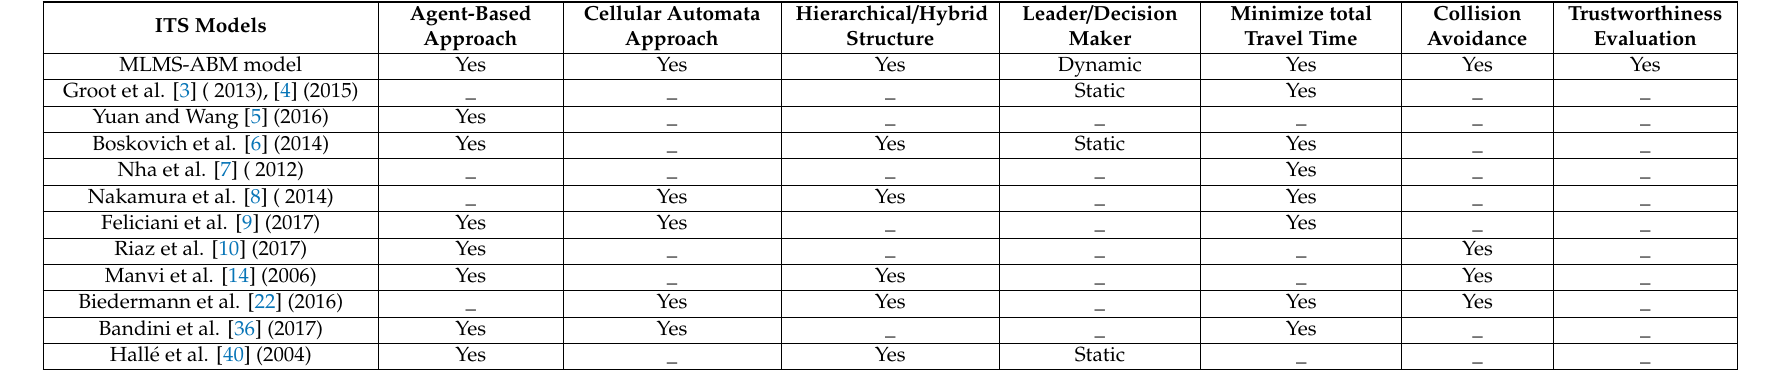
Table 1. Comparing the MLMS-ABM model and other selected intelligent transportation systems (ITS)